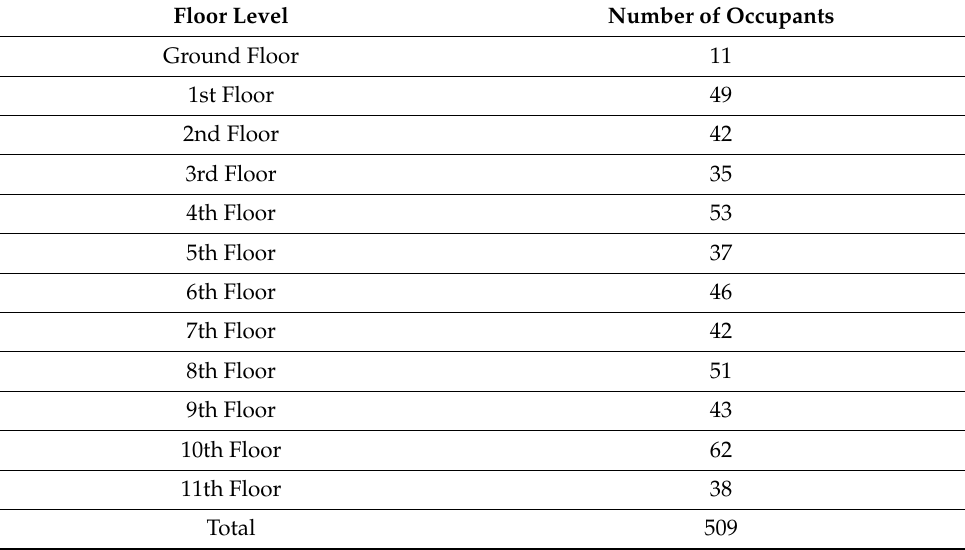
Table 1. Total number of occupants on each